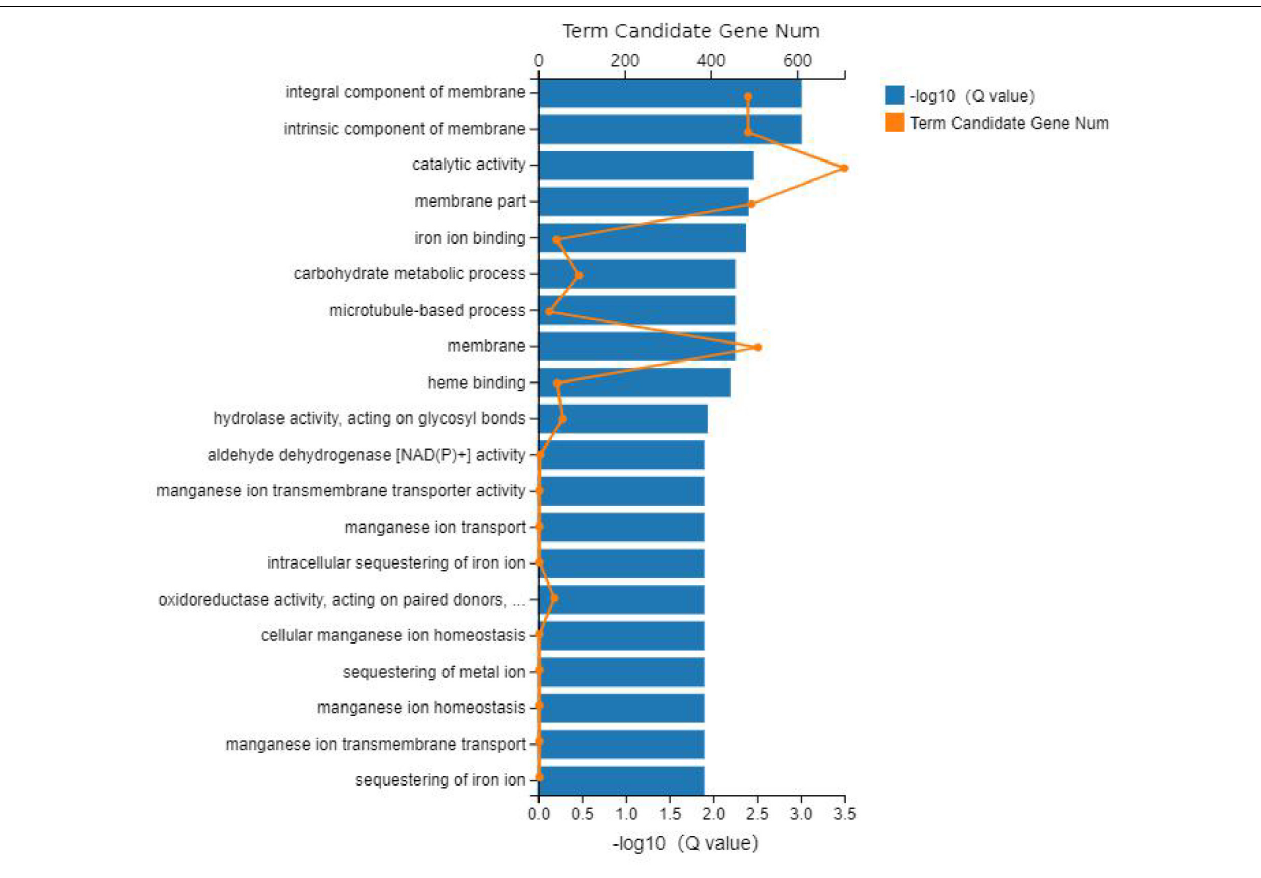
FIGURE 5 | GO enrichment figure of 1,831 DEGs in the seed coat of hull-less C. pepo